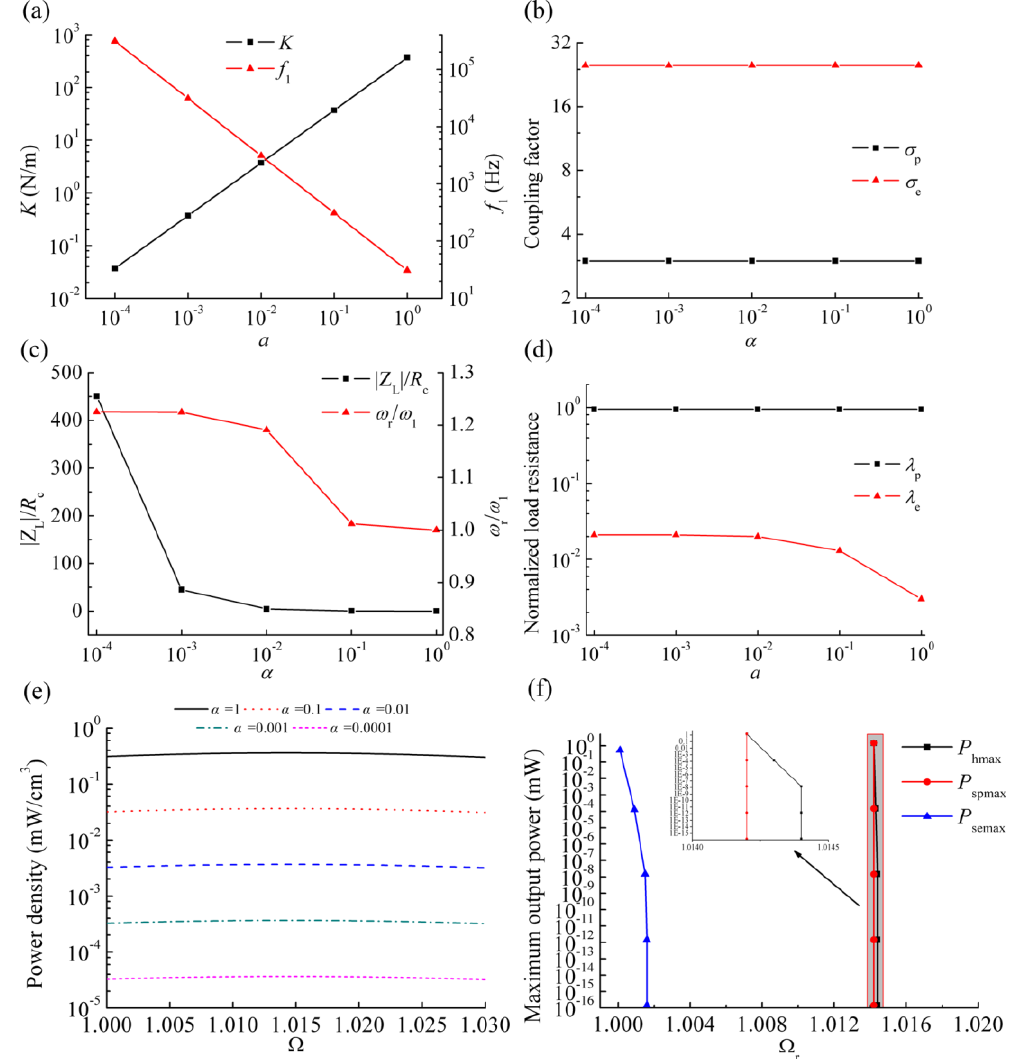
Figure 9. Performance of the HEH for different scaling factor α : ( a ) effective stiffness and undamped resonant frequency; ( b ) coupling factor ratio; ( c ) ratios of |Z L |/ R c and ω r / ω 1 ; ( d ) normalized load resistances; ( e ) power density; ( f ) Maximum output power and resonant frequency ratios for HEH, stand-alone PEH and stand-alone EMEH.